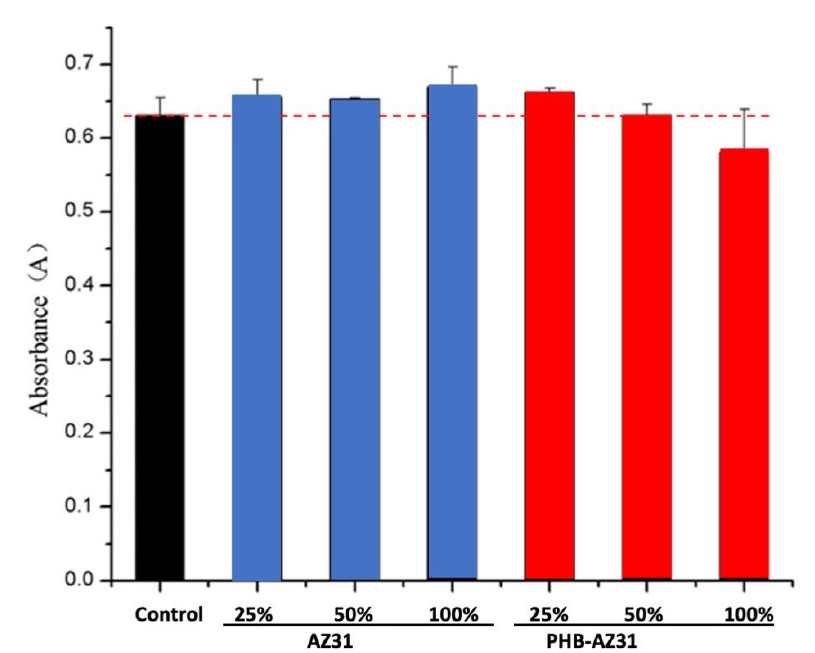
Figure 6. Nitric oxide (NO) absorbance results of the different groups.